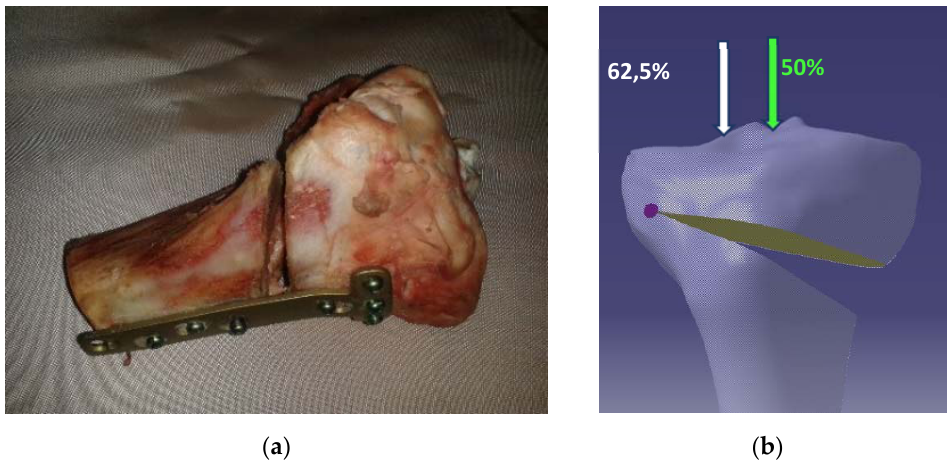
Figure 3. Positioning and mounting of the TomoFix plate ( a ); Tibia ‐ plate assembly prepared for the experiment ( b ); Correction and stressing positions.